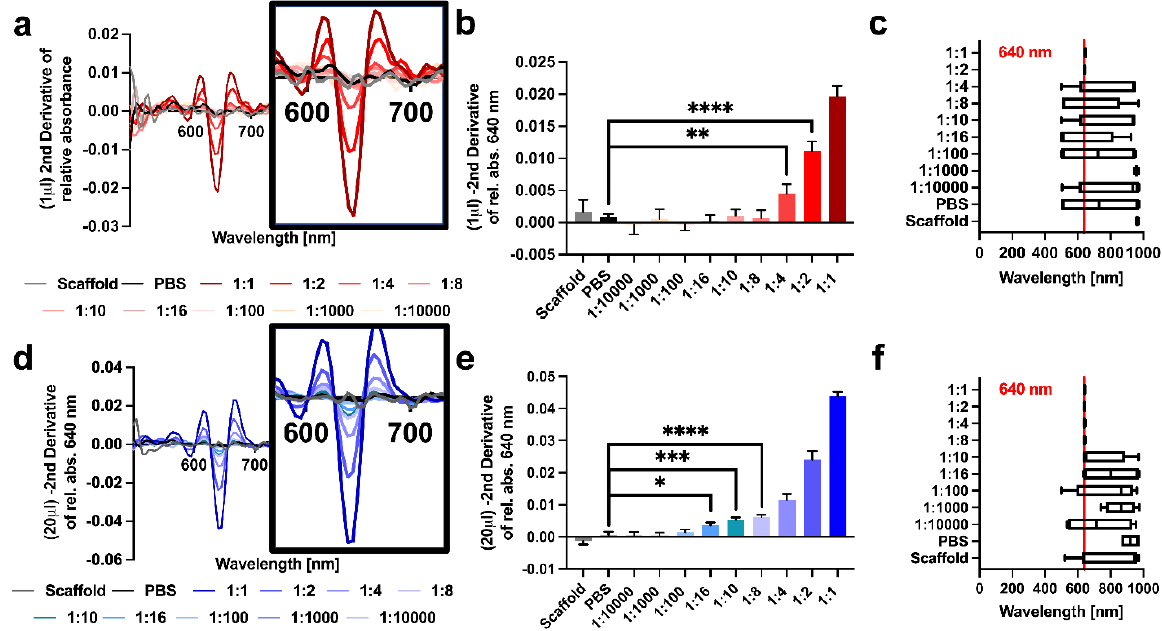
Figure 3. HSI Ab detection, concentration test at 1 mL and 20 mL. ( a ) The second derivative of relative absorbance calculated within the selected ROI in correspondence to each drop. Each signal is the average of 4 drops (N = 4) (1 mL) (min volume). ( b ) Negative second derivative of the 640 nm signal extracted from the hypercube at a 1 mL volume. ( c ) Peak test analysis where each drop peak was isolated (1 mL) (min volume). ( d ) Second derivative of relative absorbance calculated within the selected ROI in correspondence with each drop. Each signal is the average of 4 drops (20 mL) (max volume). ( e ) Negative second derivative of the 640 nm signal extracted from the hypercube at a 20 mL volume (max volume). ( f ) Peak test analysis where each drop peak was isolated (20 mL). Data are presented as mean +/ − s.d. and compared to the scaffold with one-way ANOVA, ns p > 0.05, * p ≤ 0.05, ** p ≤ 0.01, *** p ≤ 0.001, **** p ≤ 0.0001. N = 4 drops per concentration type (9 different concentrations were tested). A positive correlation between relative absorbance at 640 nm and volume was found (r = 0.9709, p = 0.0013); see Figure 4a. Data are expressed in logarithmic form. The correlation between concentration and relative absorbance at 640 nm was performed at minimum and maximum volumes (Figure 4b). Both volumes were significantly positively correlated (r = 0.9925, p < 0.0001 1 mL and r = 0.9992, p < 0.0001 20 mL, respectively). In particular, the relative absorbance exhibits a linear relationship with the HMGB1 concentration, at different volumes. Linear relationship was also found between the antibody weight (mg) and second derivative of relative absorbance at maximum volume (blue in Figure 4c) while performing concentration tests. On the other hand, the volume test revealed a non-linear relationship between weight and the second derivative of relative absorbance (red in Figure